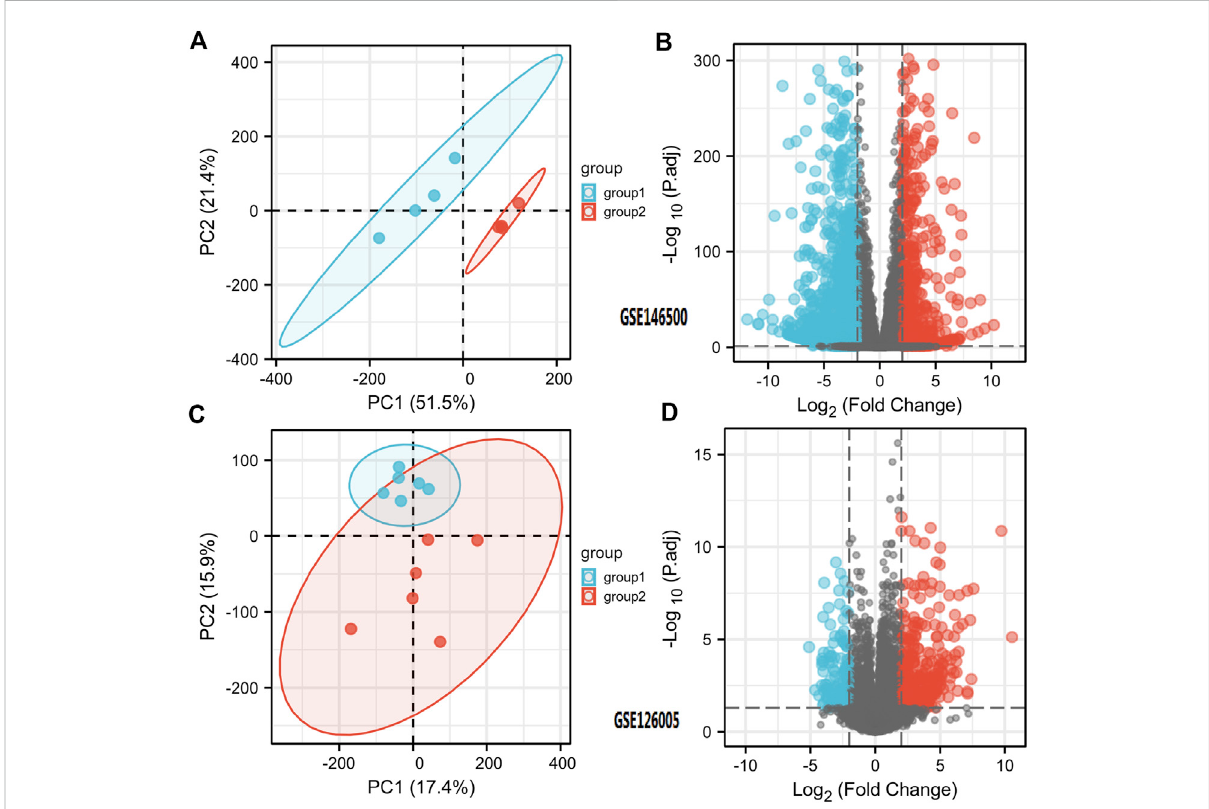
FIGURE 1 Differentially Expressed Genes in PD and Healthy Samples. (A) Principal Components Analysis for GSE146500. (B) Volcano Plot of the Differentially Expressed Genes for GSE146500. (C) Principal Components Analysis for GSE126005. (D) Volcano Plot of the Differentially Expressed Genes for GSE126005. PD = Peyronie ’ s